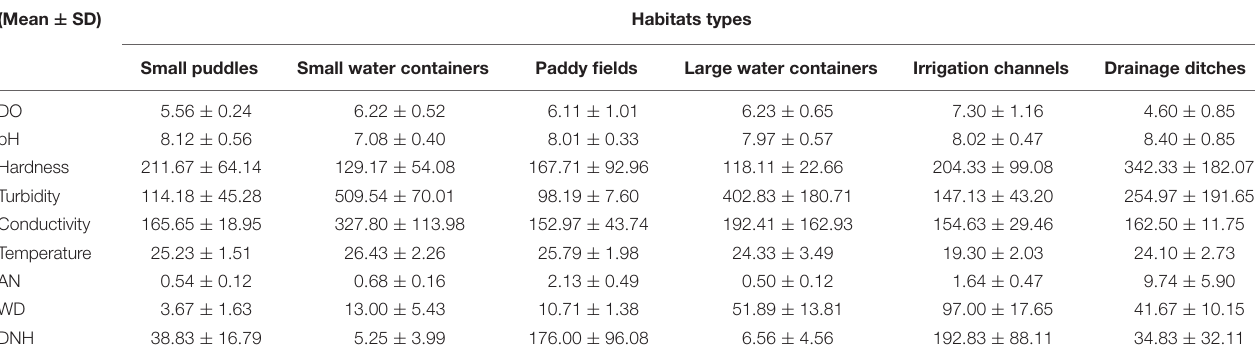
TABLE 2 | Means and standard deviations of physicochemical characteristics in different larval habitats.